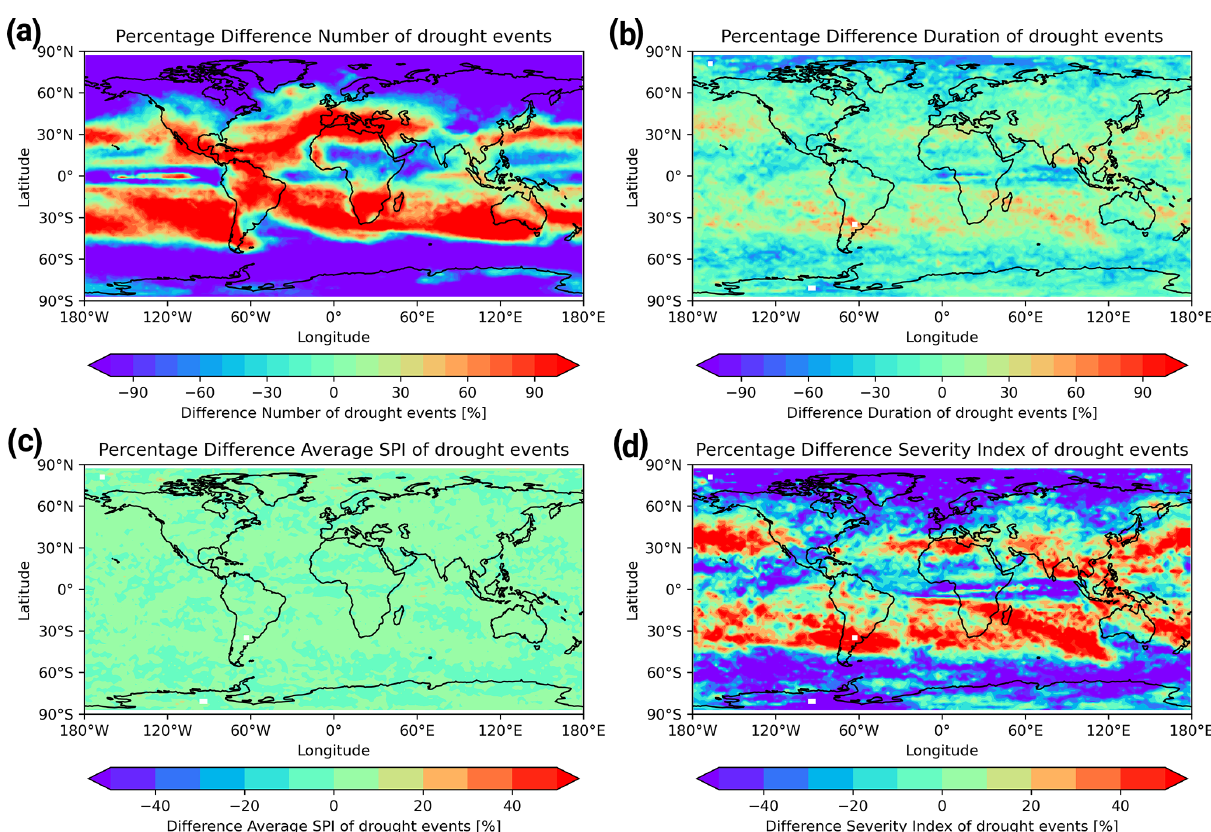
Figure 5. Difference in number (a) , duration (b) , average SPI (c) , and severity index (d) of drought events between the RCP8.5 (2050–2100) and historic (1950 to 2000) multi-model mean of 15 CMIP5 models. Here, a drought event is defined as any number of consecutive months with an SPI < − 2. For the SPI calculation a gamma distribution and a representative timescale of 6 months are used. The figure is similar to Fig. 3a–d of Martin (2018) and produced with recipe_martin18grl.yml; for details see Sect.